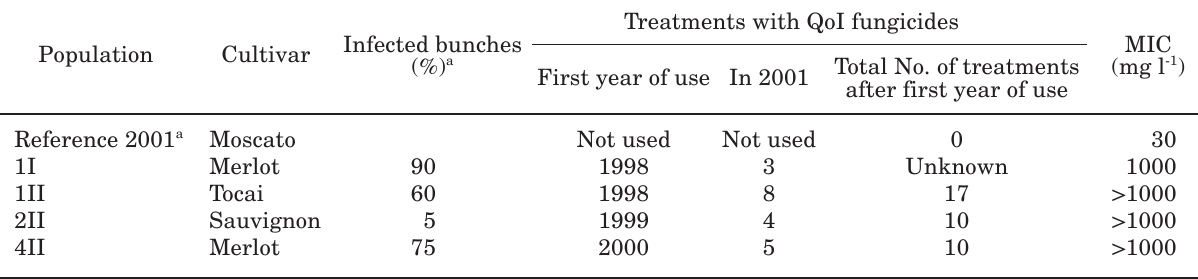
Table 3. Leaf disc test. Minimum inhibitory concentration (MIC) values, expressed in mg l -1 of azoxystrobin, in populations of P. viticola collected from vineyards in Friuli Venezia Giulia in 2001.